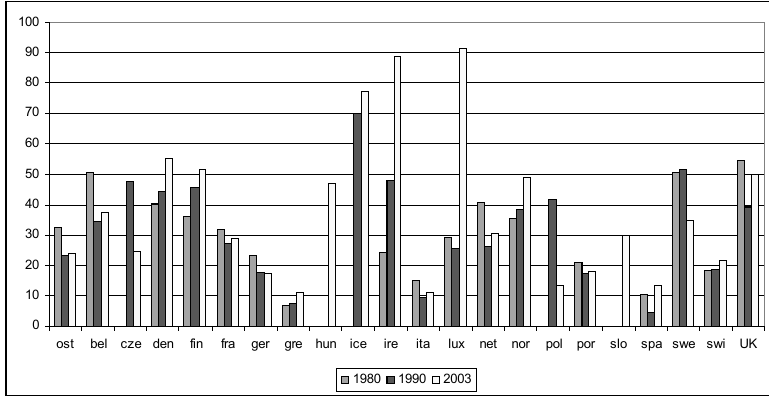
Figure 15 : Spending per old person as a % of spending per child: